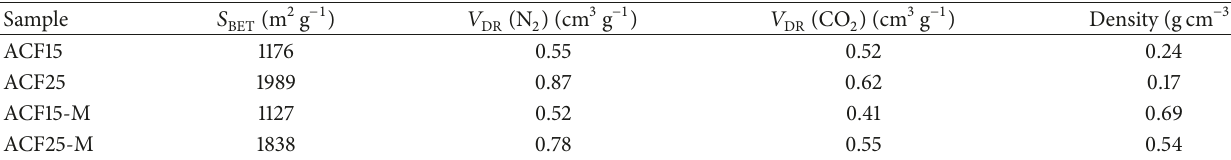
Table 1: Results from porosity